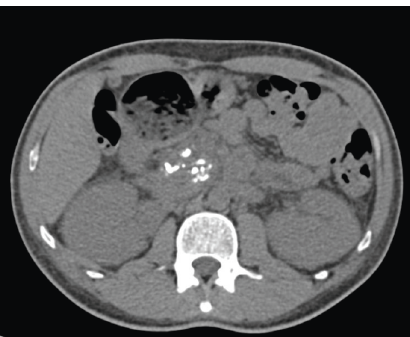
Figure 1: Axial noncontrast CT through the head of the pancreas shows coarse calcifications within the pancreatic parenchyma more pronounced in the head and uncinate process and are also seen in bilateral perinephric fat stranding.